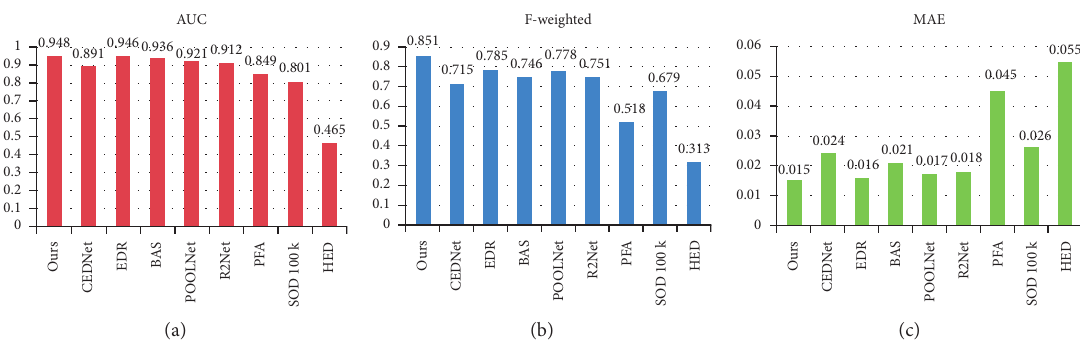
Figure 13: Performance comparison of each algorithm. (a) AUC. (b) F -weighted. (c)